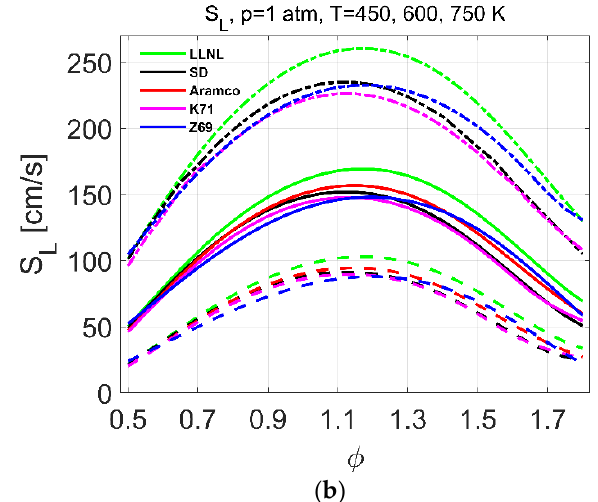
Figure 4. Laminar burning velocities for DME-air mixtures with varying pressures of 5 atm (solid line) and 10 atm (dashed line) in ( a ) and temperatures of 450 K (dashed line), 600 K (solid line) and 750 K (dot-dashed line) in ( b ). Legend: experimental data for SL from (×) Qin et al. [23] at 10 atm, ( ) and ( ▲ ) Vries et al. [26] at 5 and 10 atm, respectively, and ( ) Jomaas et al. [24] at 10 atm. Mechanism predictions from Z69 in blue, LLNL in green [28], Aramco in red [17], K71 in magenta [32] and San Diego in black [30].